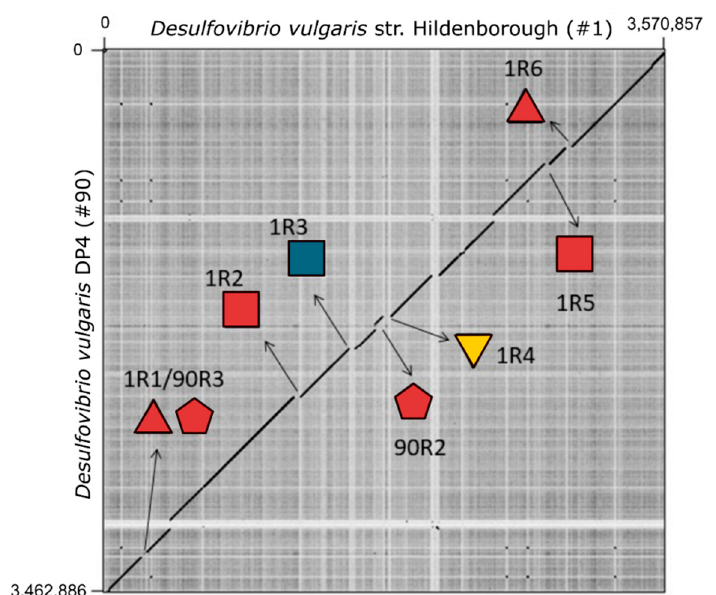
Figure 7. Dot plot matrix comparison calculated for the genomes of D. vulgaris Hildenborough and its close relative D. vulgaris DP4. Regions of similarity give rise to diagonal matches that are extended along a high proportion of the genomes. The x - and y -axis indicate full genomic chromosomal sequence comparisons of both SRP genomes. The arrows indicate seven regions that are associated with prophages found in both species. Prophages are indicated by symbols and colors according to the Virfam classification.